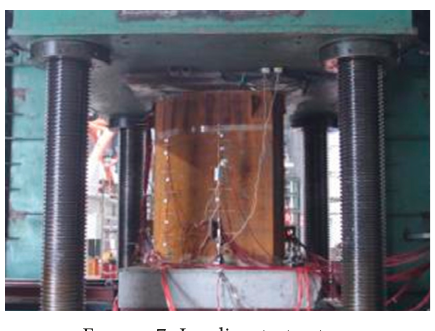
Figure 7: Loading test setup.